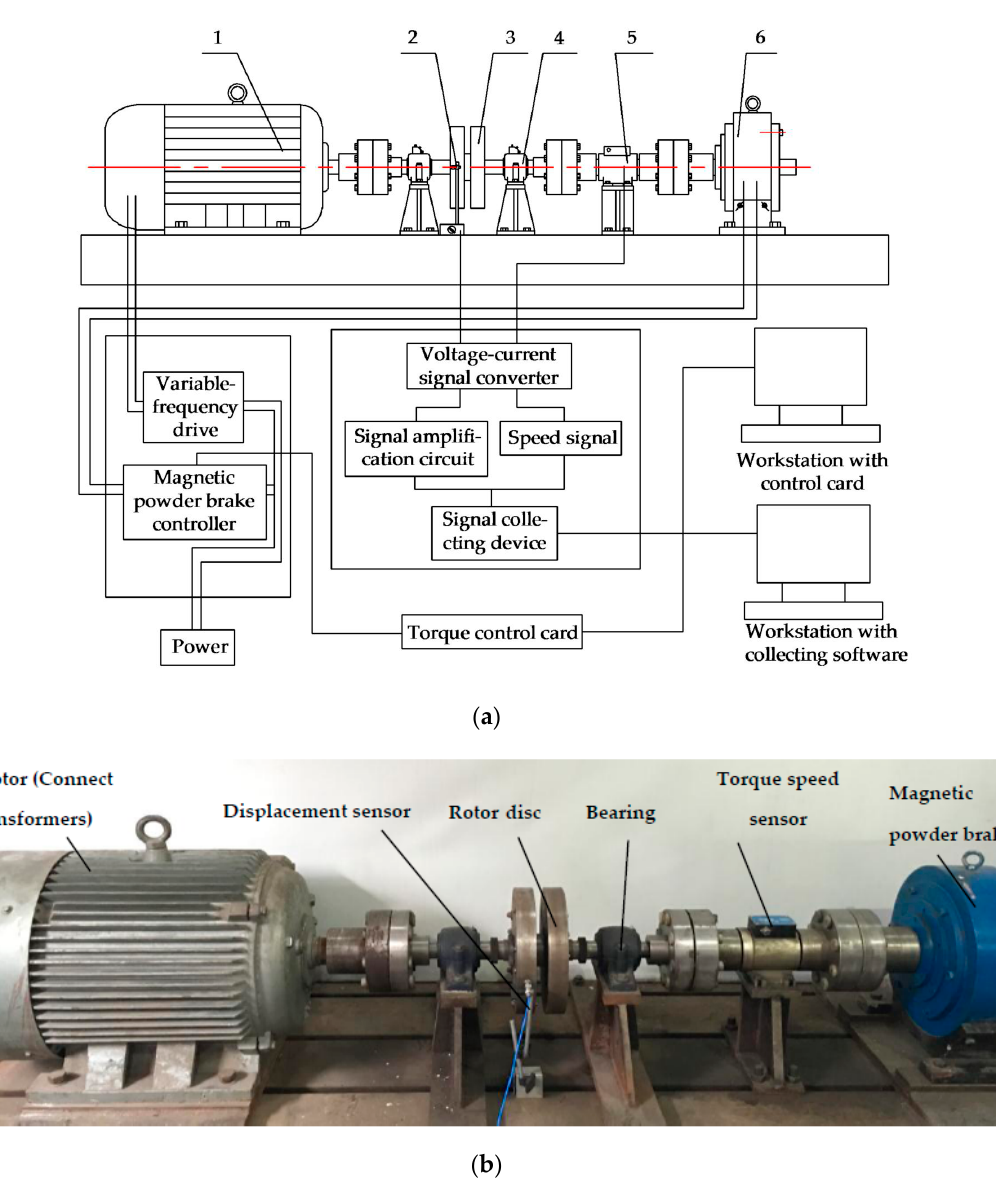
Figure 4. Load-identification test bench of rotor system. ( a ) Design schematic: 1—motor; 2—eddy current displacement sensor; 3—rotary disc; 4—bearing; 5—torque speed sensor; 6—magnetic powder brake; ( b ) Main part of load-identification test bench.